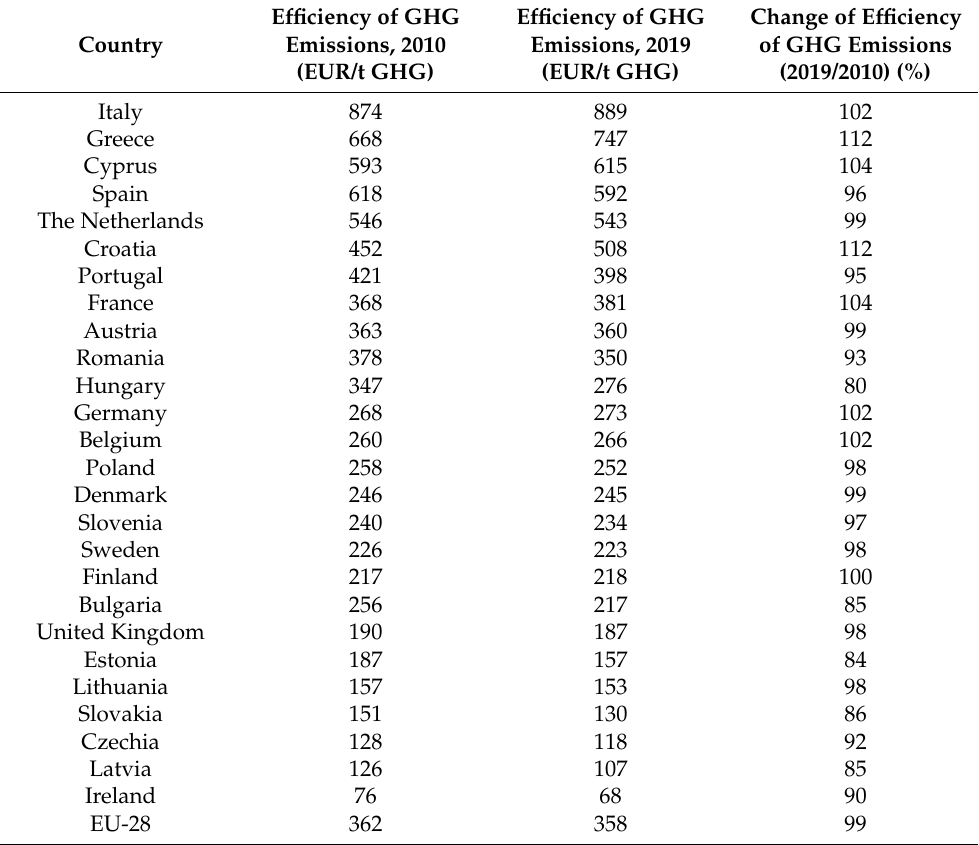
Table 6. Efficiency of greenhouse gas emissions from agriculture, 2019.